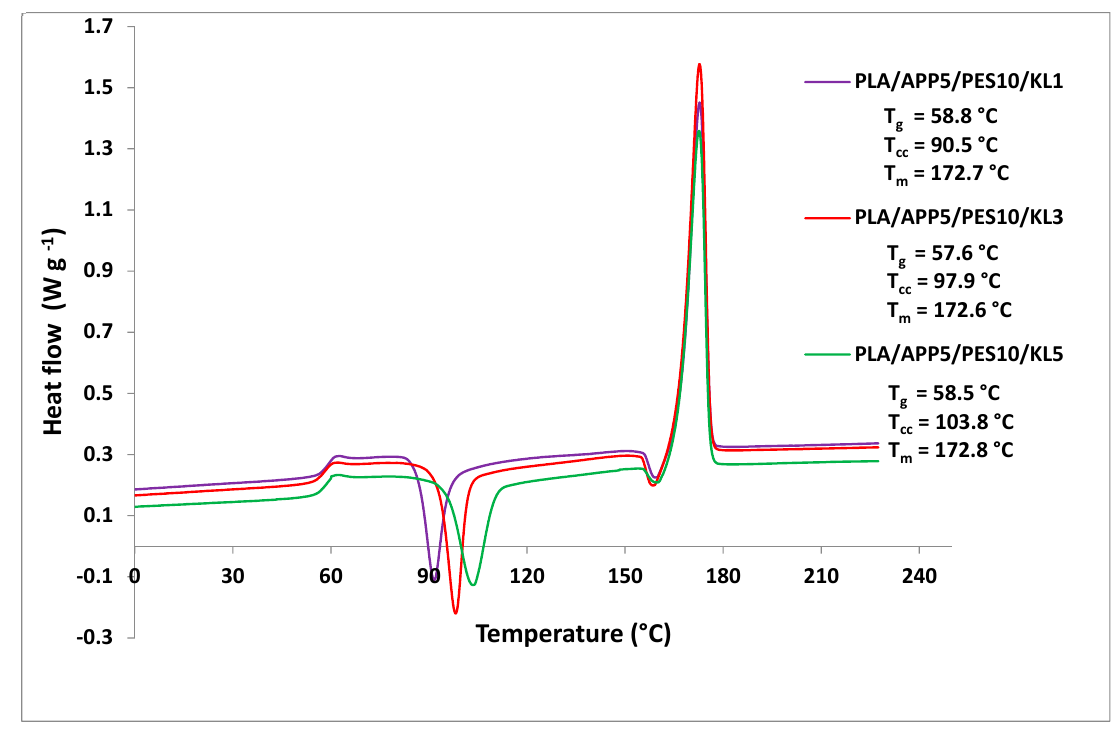
Figure 7. Differential scanning calorimetry (DSC) thermograms of bicomponent fibers. Figure 7. Di ff erential scanning calorimetry (DSC) thermograms of bicomponent fibers.